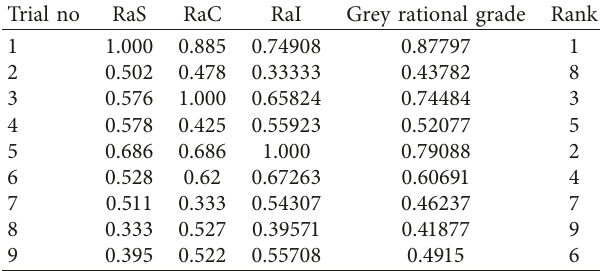
Table 6: Calculated grey relational coefficient, grade, and rank for each